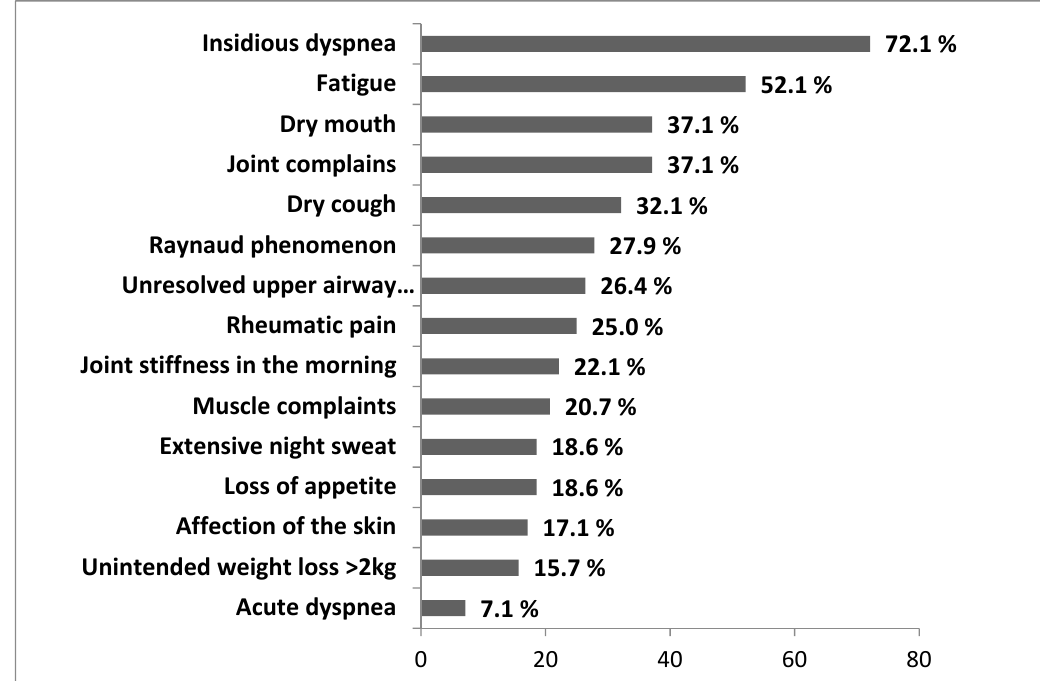
Figure 1. Spectrum of comorbidities in the uILD cohort. Data are given as percentage of all patients. Multiple comorbidities could be reported. Abbreviations: COPD—Chronic obstructive pulmonary disease, TIA—Transient ischemic attack.